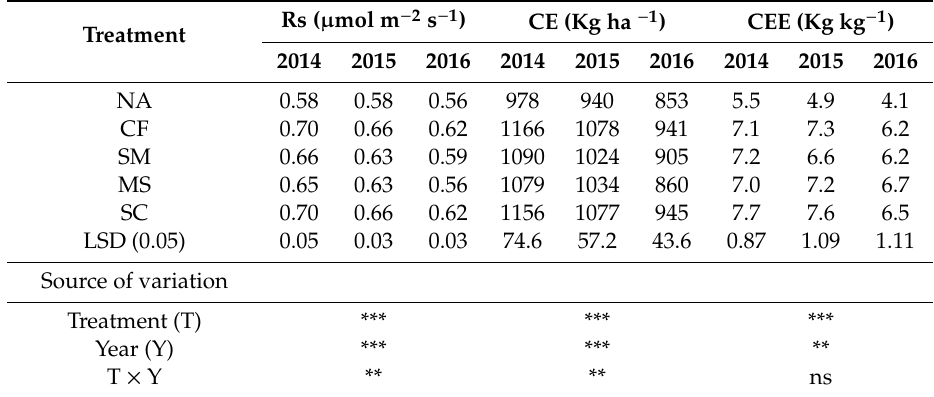
Table 5. Growing season soil respiration (Rs, carbon emission (CE) and carbon emission e ffi ciency (CEE)) by soil amendment treatment in maize in 2014, 2015, and 2016.